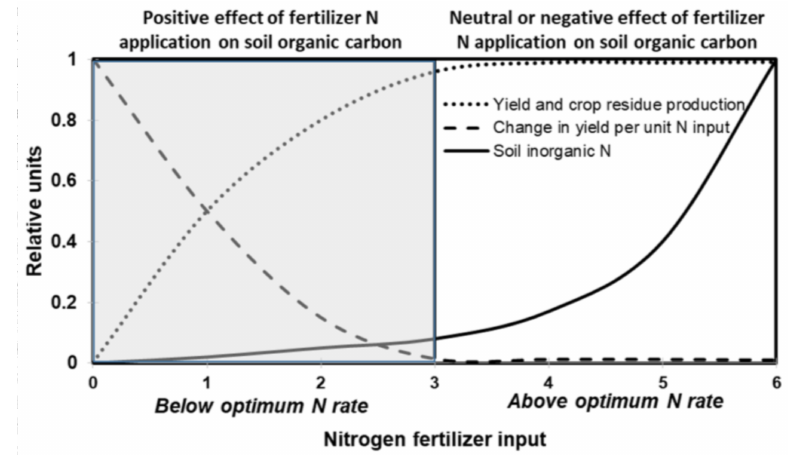
Figure 1. Conceptual diagram showing possible effects of fertilizer application to crops on SOC as defined by relationships between increasing fertilizer N application levels and (i) yield and crop residue production, (ii) change in yield per unit N input, and (iii) residual soil inorganic N. Maximum yield of the crop is obtained at the optimum N rate. Expected SOC responses to fertilizer N application below and above optimum N rate are shown above the grey and white areas of the plots, respectively (Modified from Poffenbarger et al.